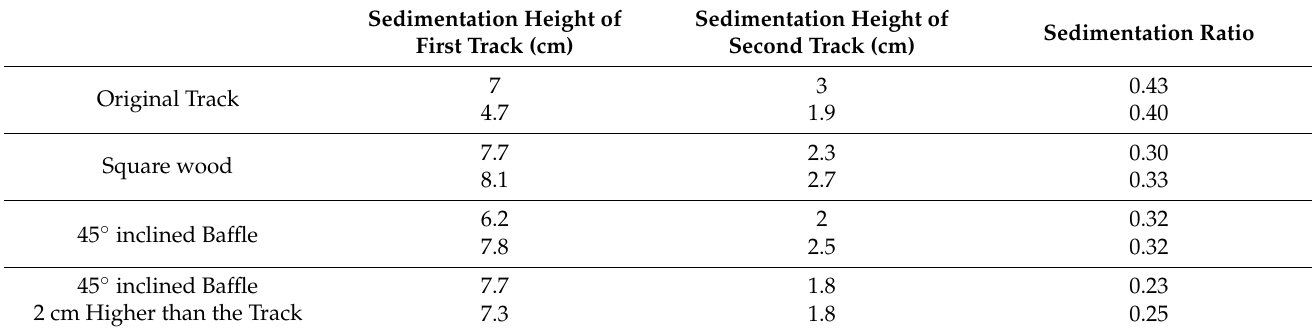
Table 2. Field experiment